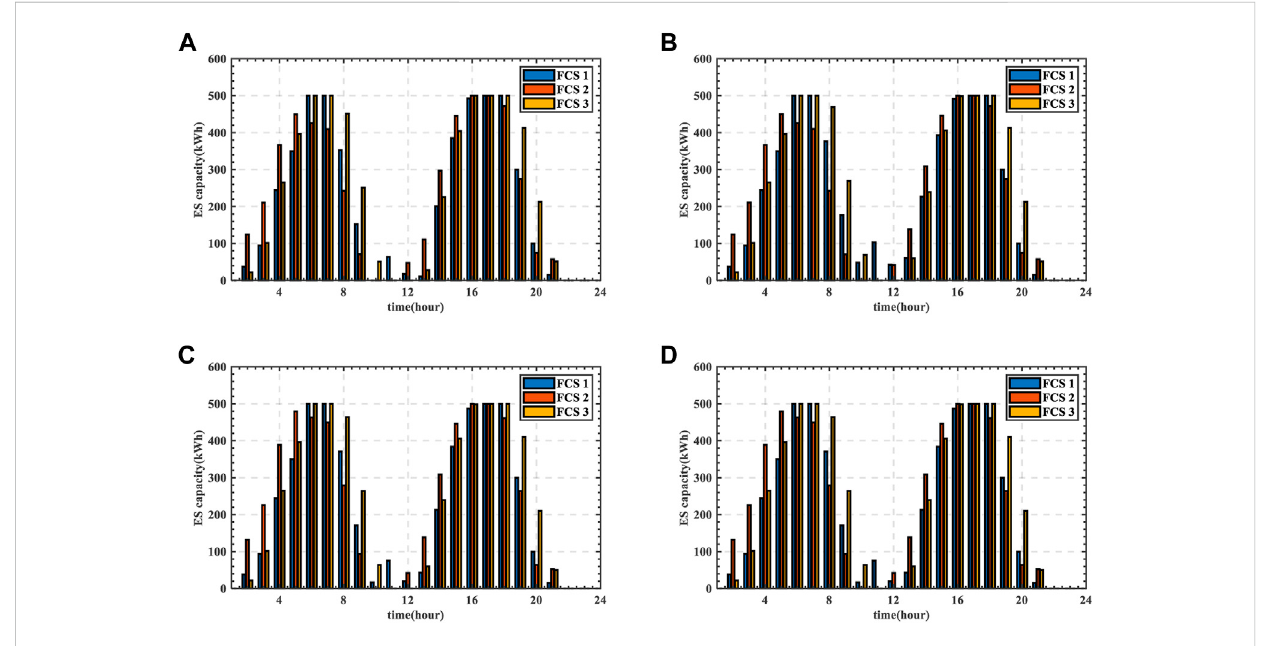
FIGURE 15 ES operation status of scenario 2 for the shortest path.